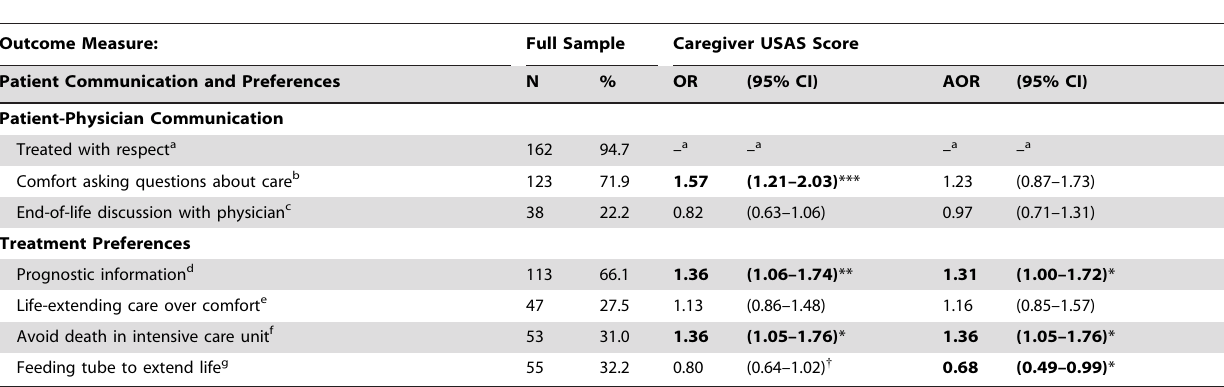
Table 5. Associations between Caregiver Acculturation and Patient-Physician Communication and Patients’ Treatment Preferences (N= 171).